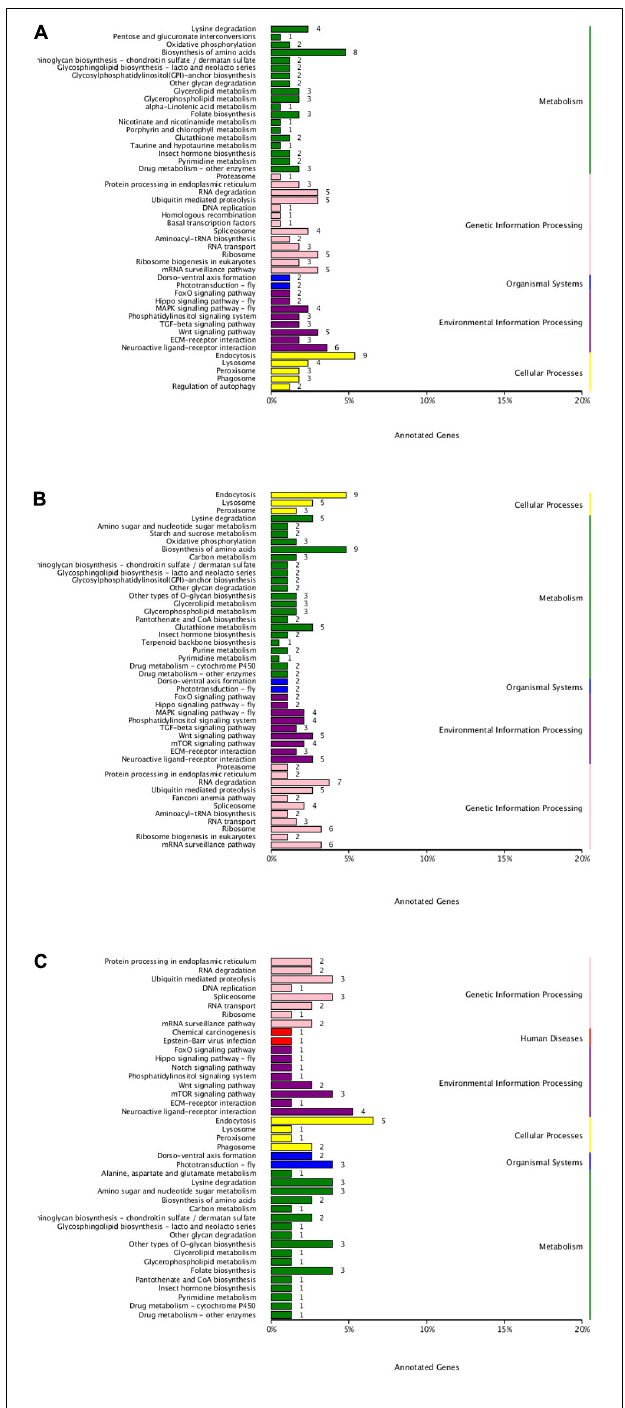
FIGURE 6 | KEGG classification of DEMs. (A) EP vs. PH. (B) EP vs. L. (C) PH vs. L. The ordinate represents the name of the KEGG pathway. The abscissa represents the number of genes annotated into the pathway.